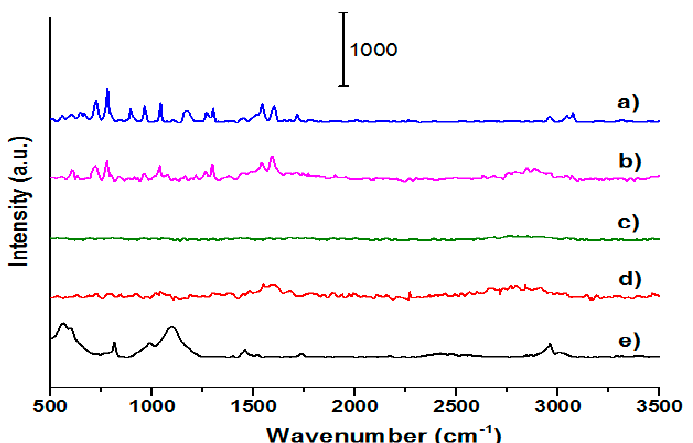
Figure 6. Raman spectra of ( a ) 100 mg / L of thiophanate methyl deposited glass, ( b ) 5 mg / L of